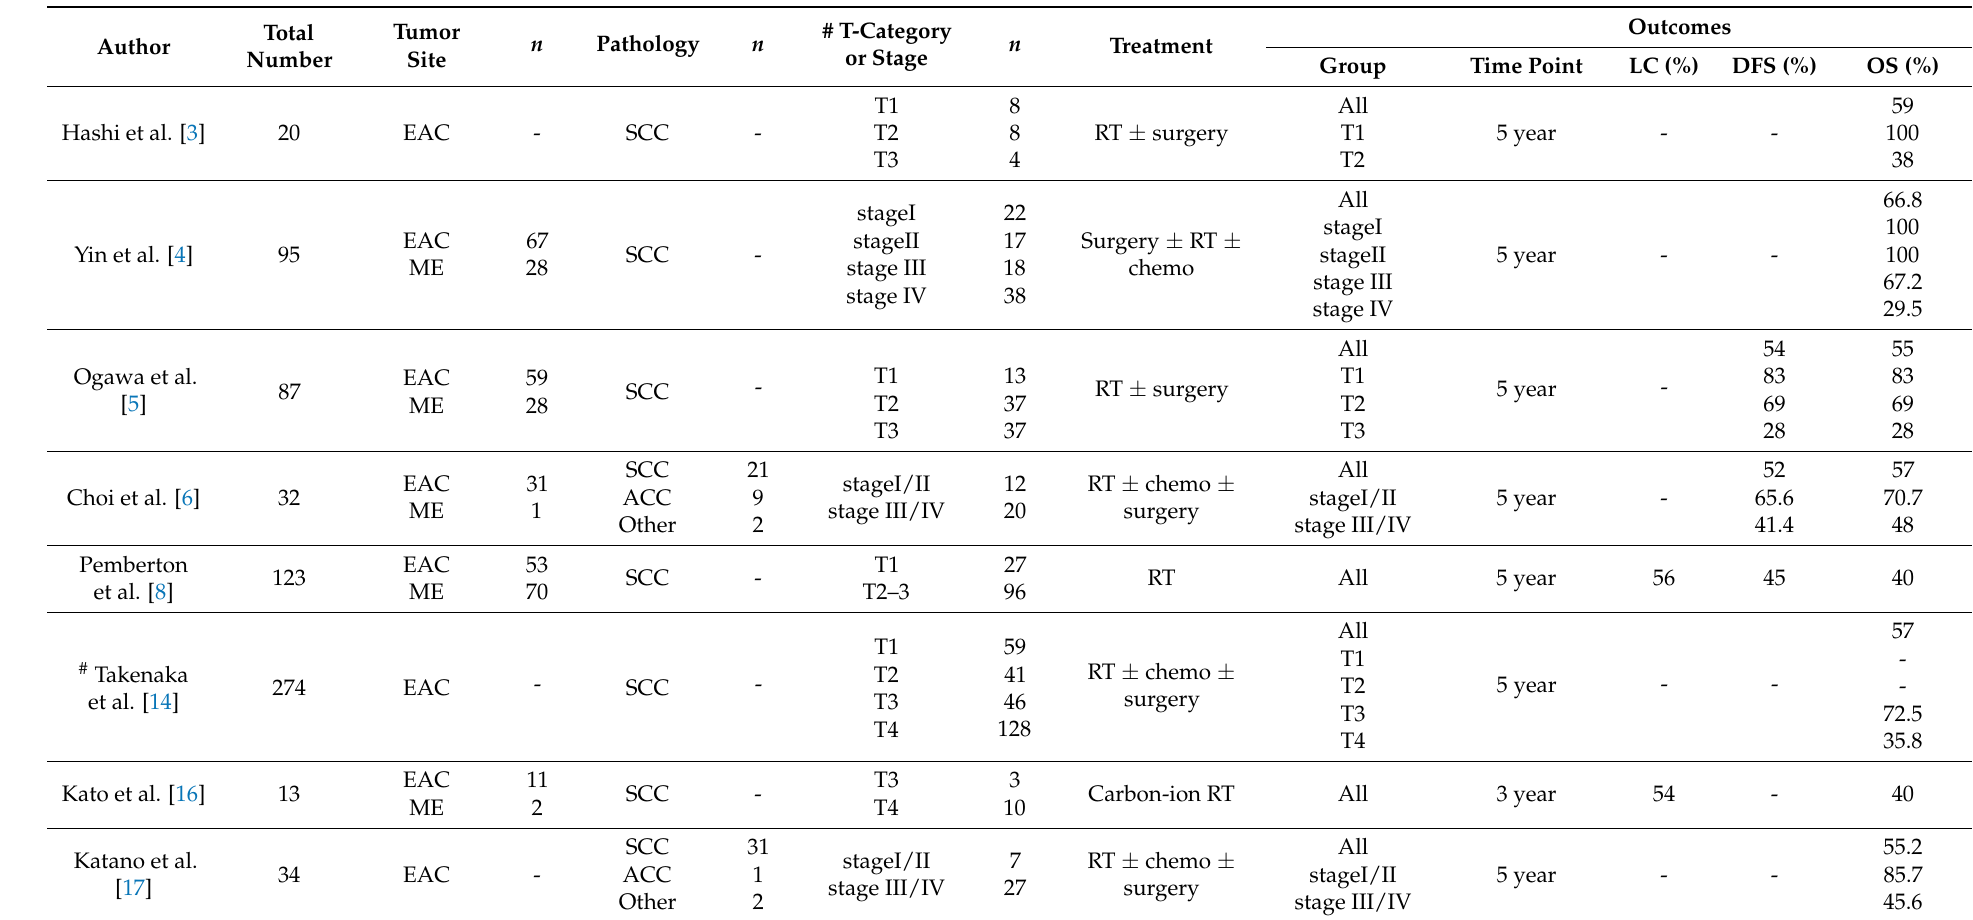
Table 5. Data summary of the cited